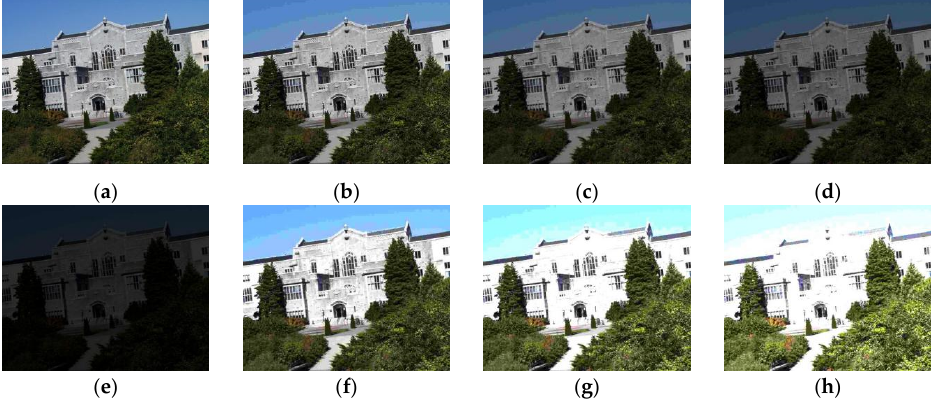
Figure 8. Ubc sequence. ( a ) Normal Ubc; ( b ) New Ubc with a JPEG compression of 90%; ( c ) New